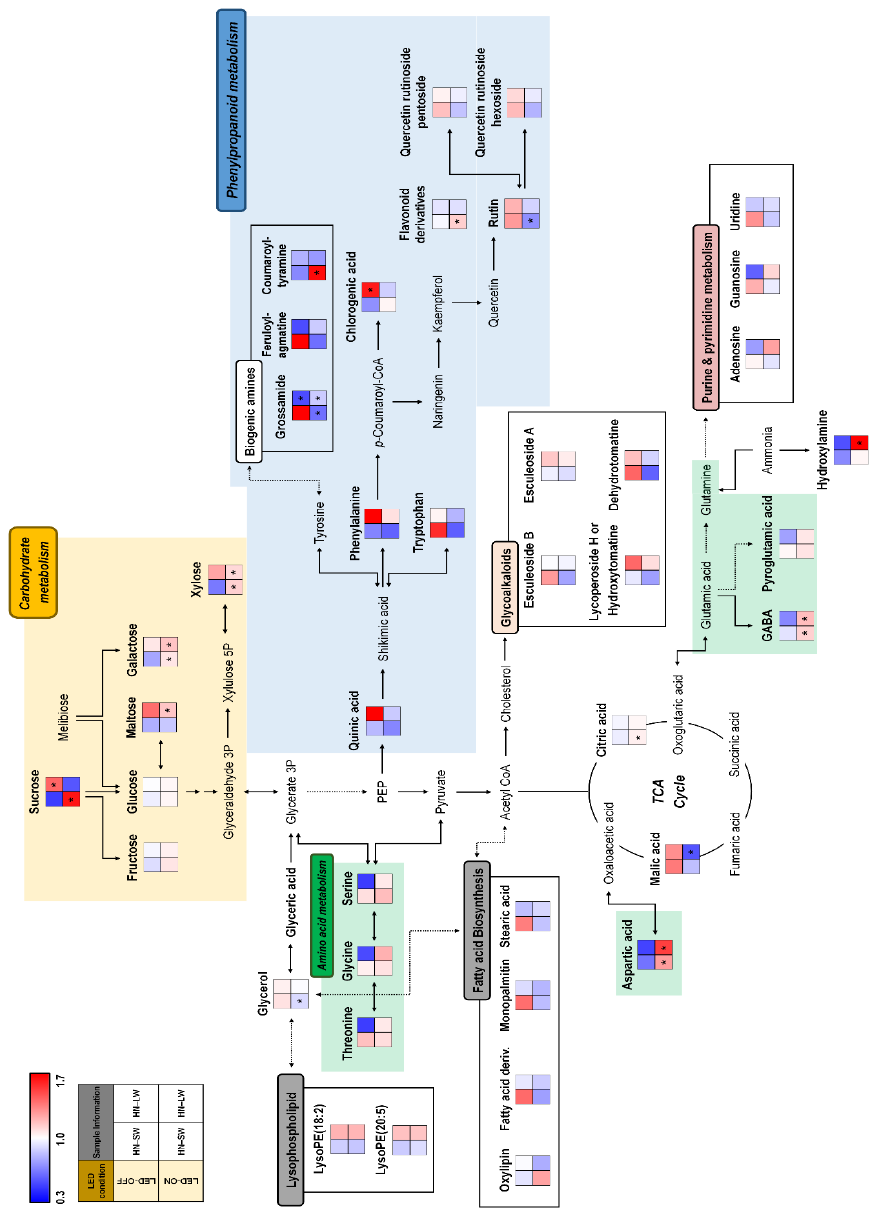
Figure 5. Constructed metabolic pathway for relative metabolite contents of tomato cultivated under different water and light condition for high N soil. The metabolic pathway was modified from the KEGG pathway database (https://www.genome.jp/kegg/pathway.html; URL accessed on 4 of June 2021). The colored squares (blue to red) indicate fold changes normalized by the average of each metabolite. * Significantly different metabolite from control (HN-SW-OFF) evaluated by t -test ( p < 0.05).